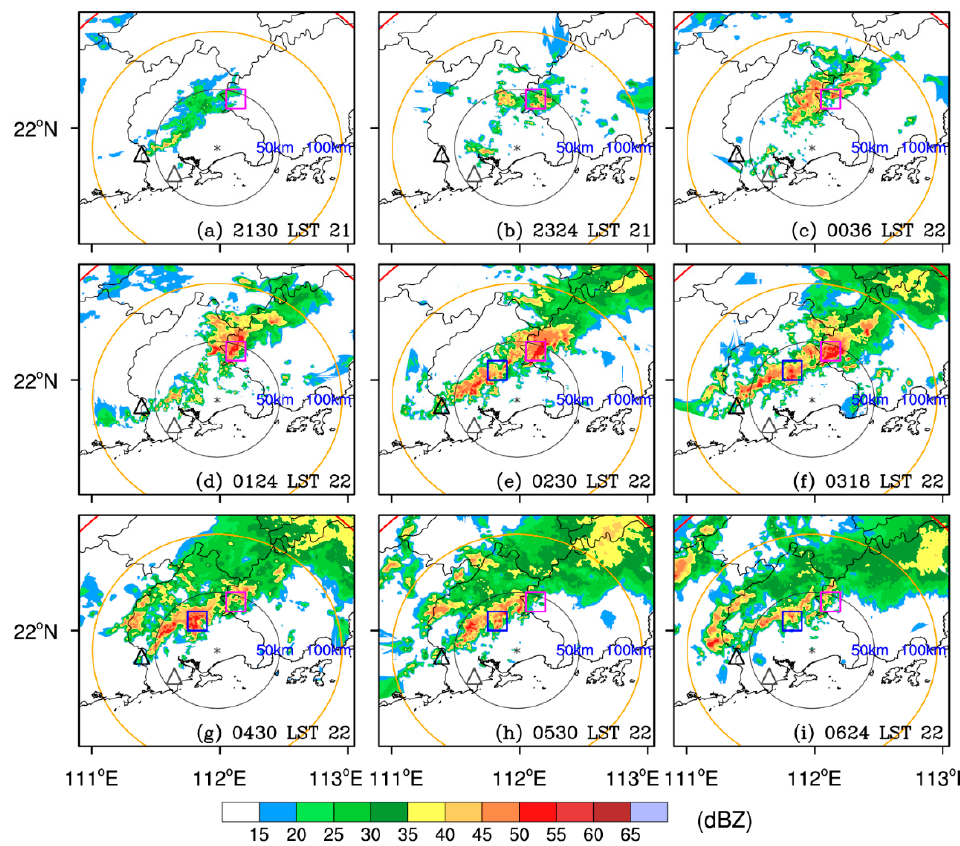
Figure 3. Radar reflectivity ( Z H , dBZ) of YJ S-POL (1.5 ◦ elevation) at ( a ) 2130 LST 21, ( b ) 2324 LST 21, ( c ) 0036 LST 22, ( d ) 0124 LST 22, ( e ) 0230 LST 22, ( f ) 0318 LST 22, ( g ) 0430 LST 22, ( h ) 0530 LST 22 and ( i ) 0624 LST 22. The asterisk represents the location of YJ S-POL; circles represent distances 50 km and 100 km from the radar. The solid magenta line box represents the key region. The blue solid-line box represents another strong convection area centered near Gangmei. Black and gray triangles represent the Mt. Ehuangzhang and Mt. Longgao, respectively.